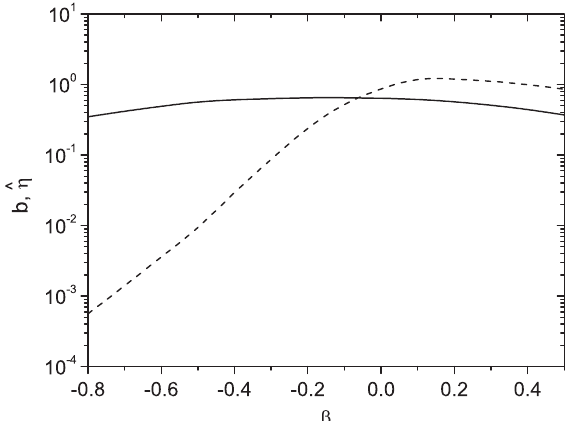
FIG. 2. Ensemble-averaged rms bunching factor (solid) and normalized FEL efficiency (dash) at saturation point (position with maximum bunching factor) versus taper strength parameter. ^(cid:2) ¼ 0 : 2 Energy spread parameter is T